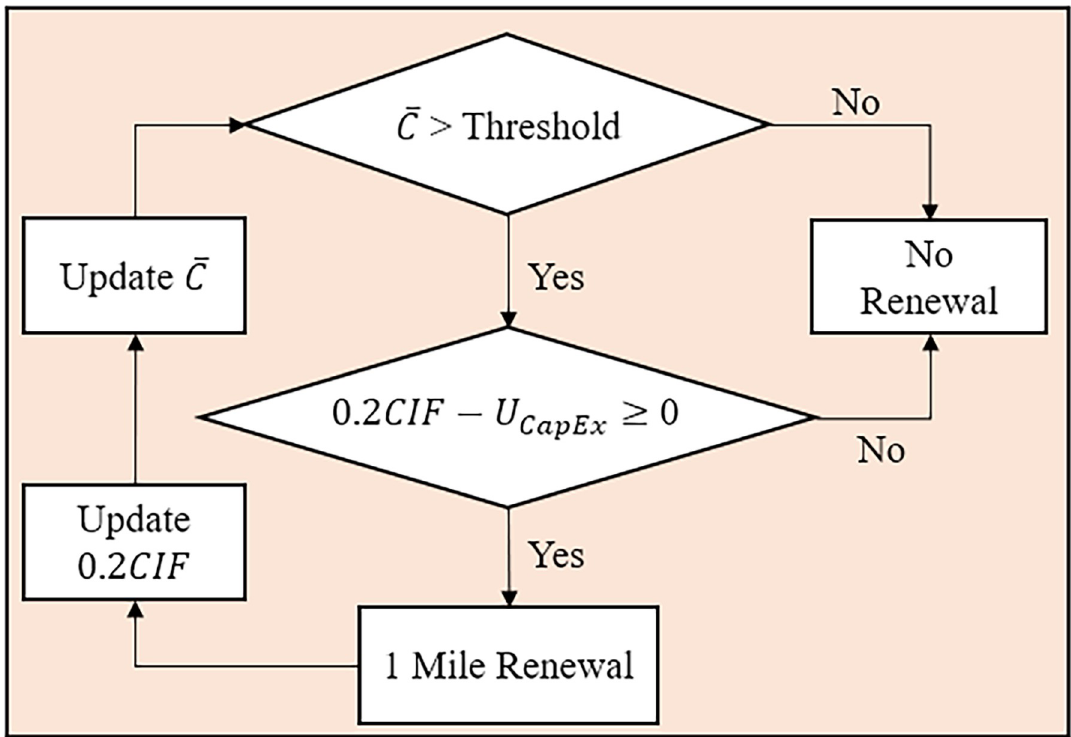
Fig 6. Action chart of renewal strategy for controlling network average